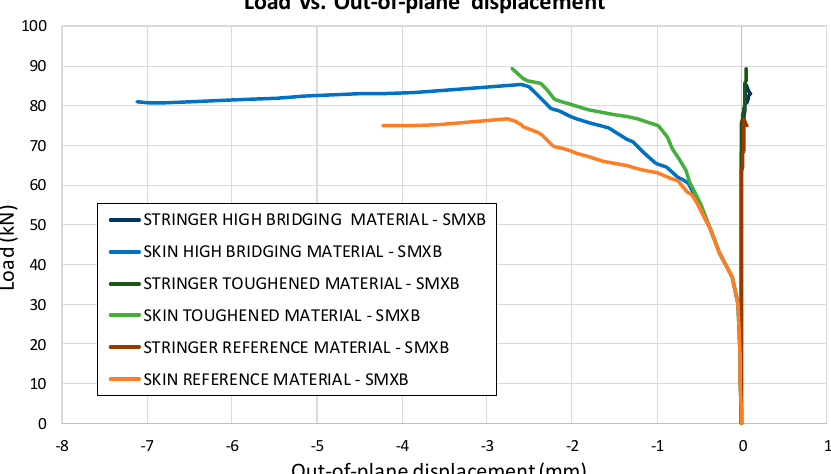
Figure 10. Load vs. Out-of-plane displacements (SMXB). Table 2. Delamination onset and buckling load (SMXB).